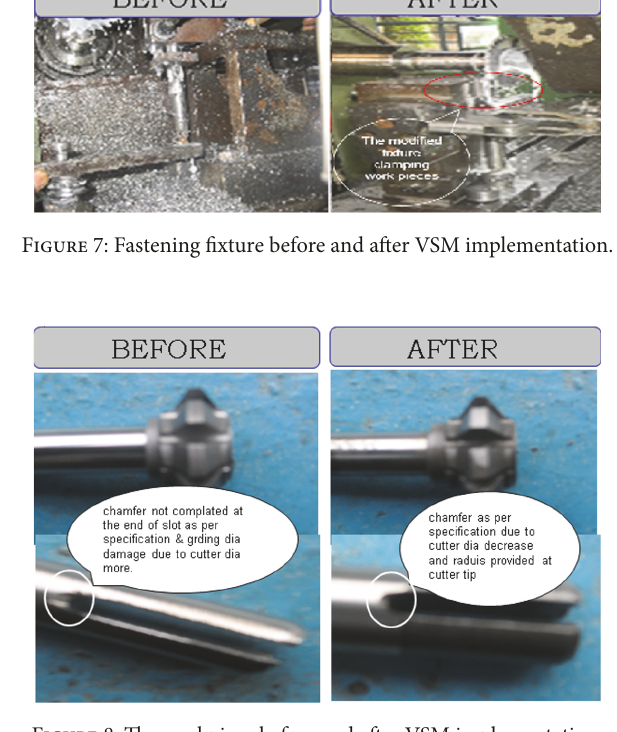
Figure 8: The workpiece before and after VSM implementation.